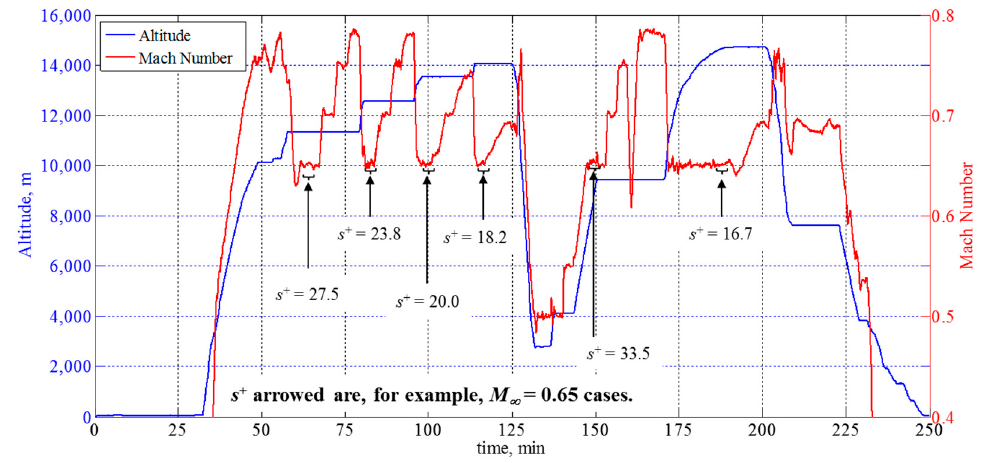
Figure 3. Representative flight history showing flight Mach numbers and altitudes.